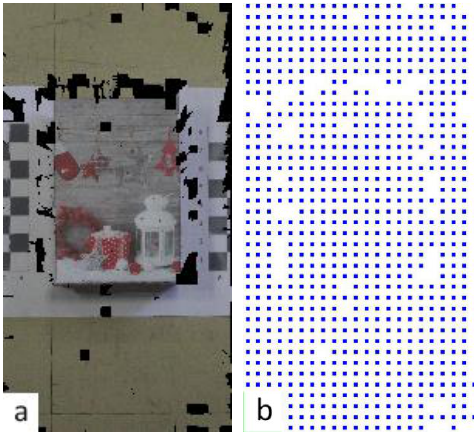
Figure 5. Orthophoto (a) and DSM (b) generated by MAGO. The orthophoto derived from MAGO and Agisoft Metashape© using the same settings, i.e. orthophoto plane, pixel size, orthophoto boundaries, processed image and input point cloud, are compared in the following.